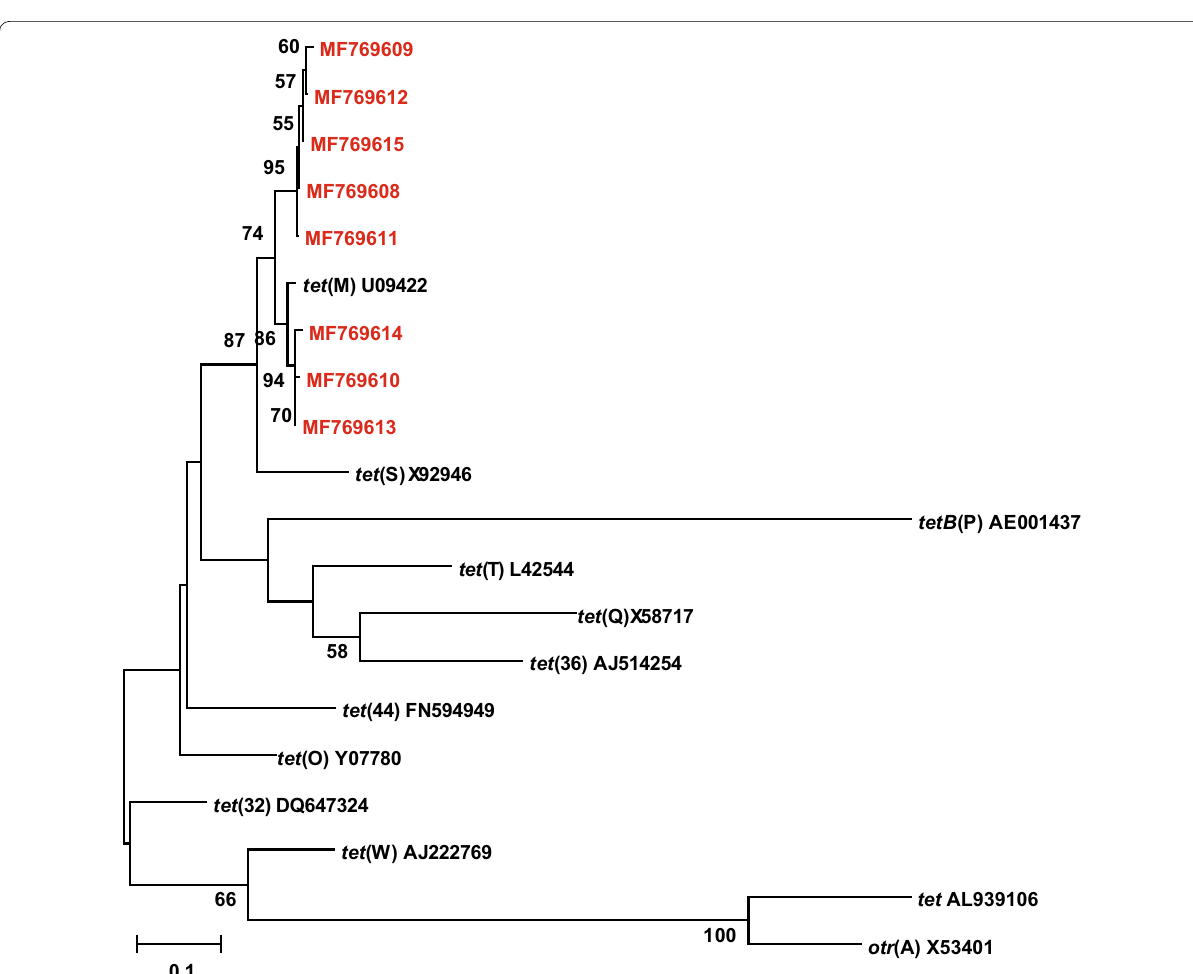
Fig. 2 Neighbor-joining phylogenetic tree based on sequences of the RPPs gene (245 bp). The tetracycline resistance genes identified in our study (MF769608–MF769615, in red font) are the most similar to tet (M). Bootstrap percentage values greater than 50% are given at the nodes of the